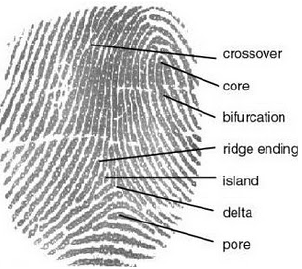
Figure 1. Fingerprint Structure.